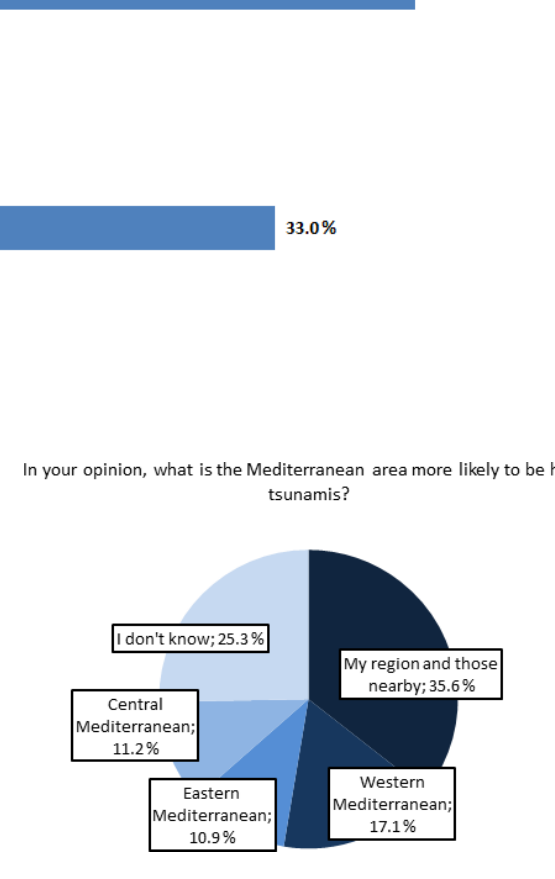
Figure 4. Mediterranean areas perceived as the most prone to be hit by a